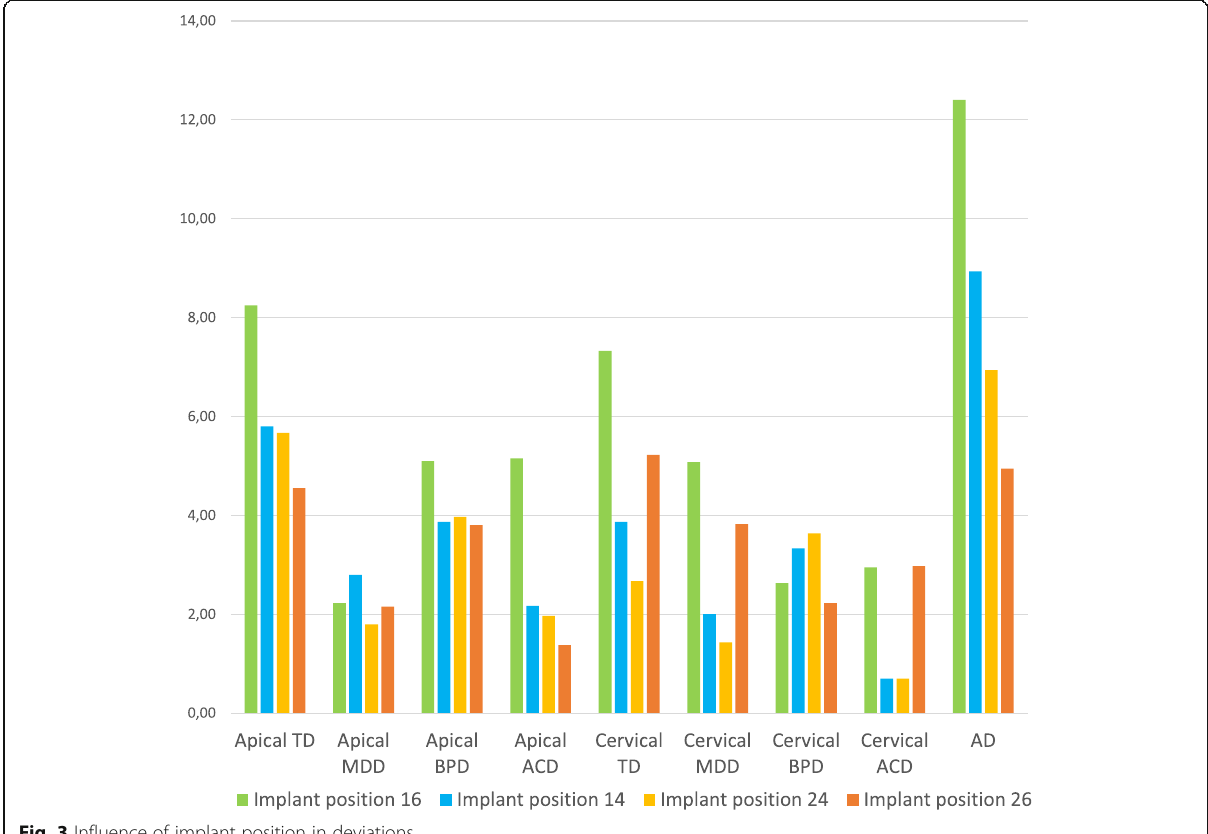
Fig. 3 Influence of implant position in